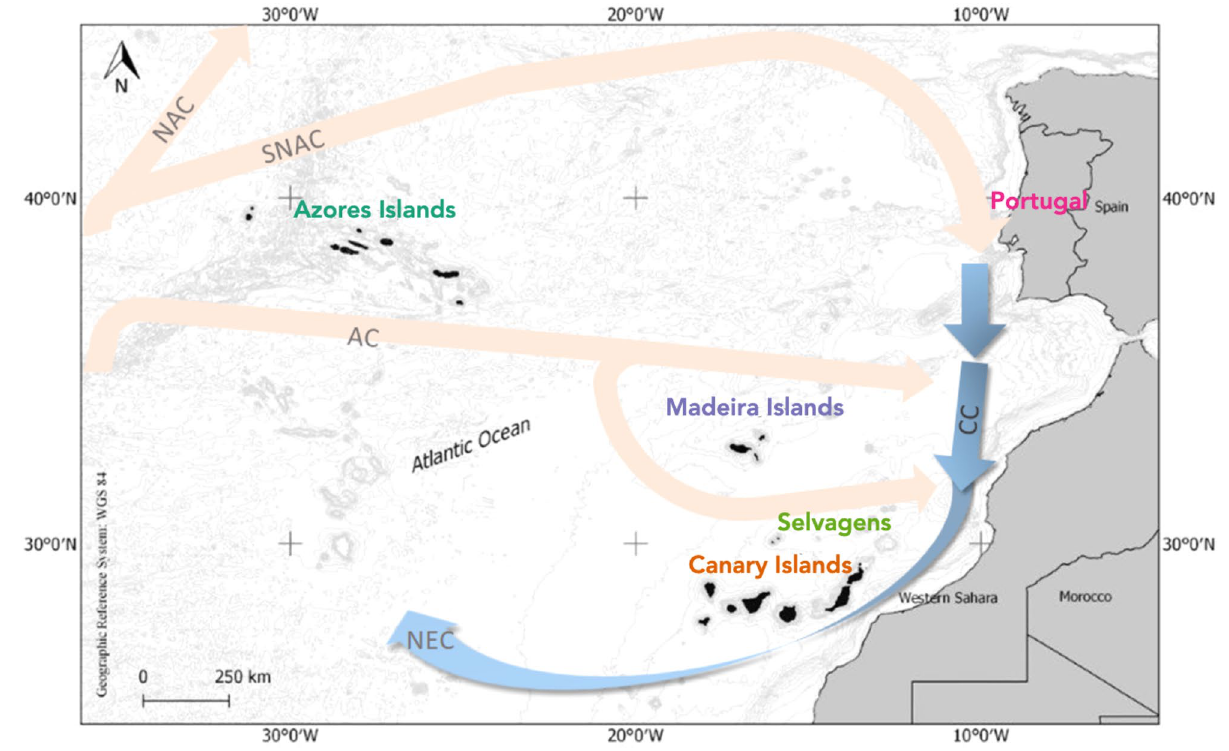
Figure 1. Sampling locations of the mollusc Phorcus sauciatus in coastal areas from the Atlantic Ocean (mainland Portugal and the islands of Madeira, Selvagens, Azores and the Canaries) including the North Atlantic Current (NAC), Southern limb of the North Atlantic Current (SNAC), Azores Current (AZ), Canary Current (CC), and the North Equatorial Current (NEC). Map made with QGIS (v 3.6, https:// www. qgis. org) 32